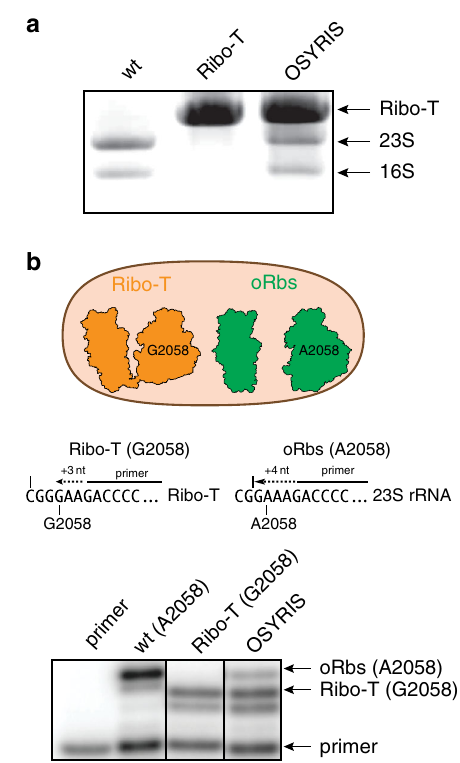
Fig. 2 Performance of the dissociable orthogonal ribosome in the OSYRIS cells. a Gel electrophoresis analysis of the large rRNA species in the OSYRIS cells in comparison with wild type (wt) E. coli , containing only dissociable 70S ribosomes, and with Ribo-T cells (Ribo-T) which only carry tethered ribosomes. b Primer extension analysis of the rRNA content in the OSYRIS cells. Top, Ribo-T and the dissociable ribosome can be distinguished because of the A2058G mutation present in the Ribo-T rRNA. Middle, the principle of the primer extension analysis: in the presence of ddCTP, reverse transcriptase extends the primer by 4 nts on the 23S rRNA template (with A2058) but only by 3 nts on the Ribo-T rRNA template (with G2058). Bottom, gel electrophoresis analysis of the primer extension products generated on the rRNA extracted from wt, Ribo-T, or OSYRIS cells. The representative gels of three (panel a ) or two (panel b ) independent experiments are shown. Uncropped gel corresponding to panel a can be found in the Source data fi